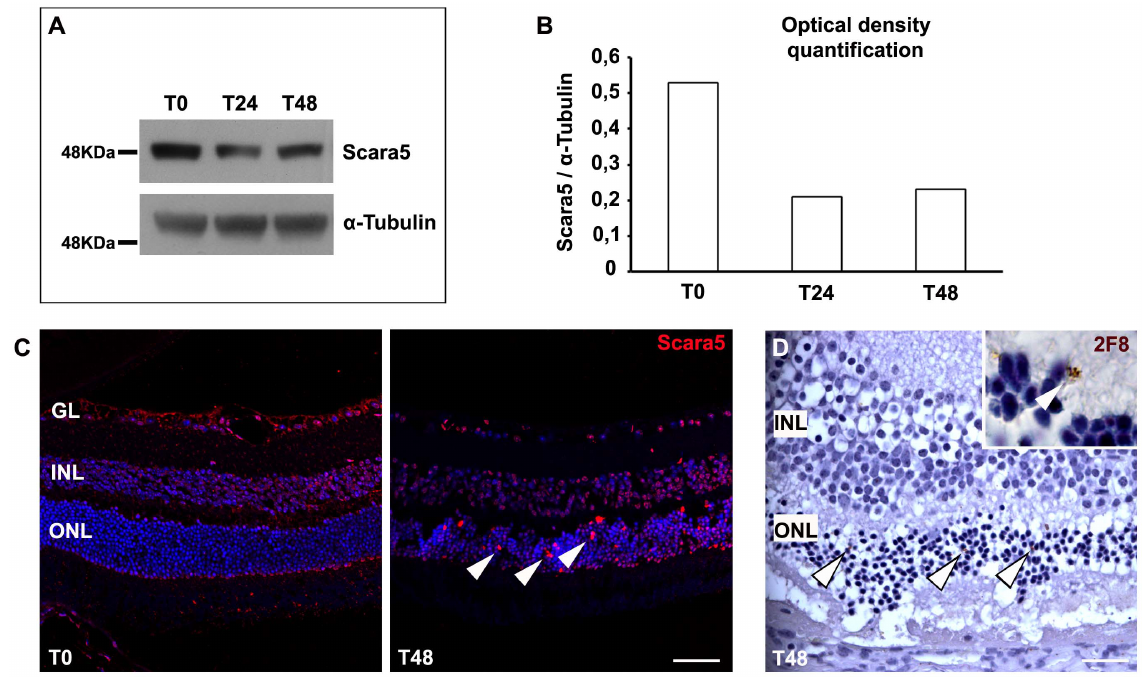
Figure 10. Scara5 expression decreased during retinopathy. A: Retinas of a sodium iodate murine model were analyzed by western blotting. Scara5 expression reduced to about half during the treatment. B: Graph representing the optical density quantification of the Western blotting analysis for Scara5, after normalization with respect to a -tubulin. C: The immunolabeling of paraffin-embedded retinal sections with anti-Scara5 antibody confirmed that Scara5 expression decreased throughout the parenchyma. However, several positive Scara5 cells were found in the outer nuclear layer (arrowhead). D: During retinopathy, 2F8 positive cells were also observed in the outer nuclear layer (arrowhead), with a disposition compatible with that of Scara5 positive cells. 2F8 was revealed by DAB reaction and histological sections were counterstained with hematoxylin. GL, ganglion cell layer; INL, inner nuclear layer; ONL, outer nuclear layer. Scale bars: 45 m m (C); 20 m m (D).